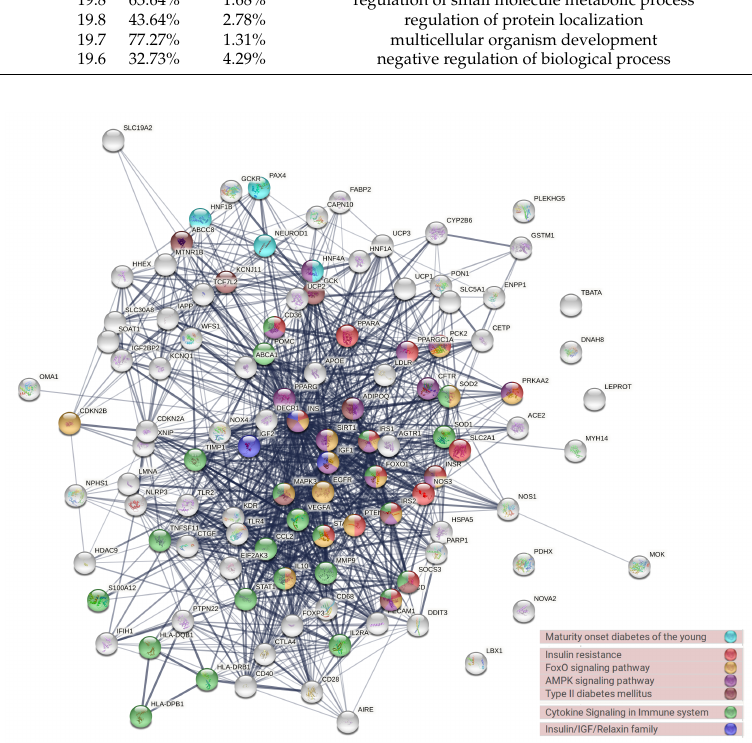
Figure 5. The protein–protein interaction network of the most common genes in the diabetes literature and their associated biological